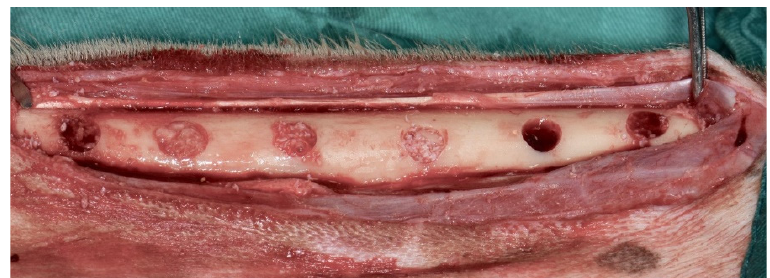
Figure 3. Defects were filled with test group graft materials and control group was left empty.